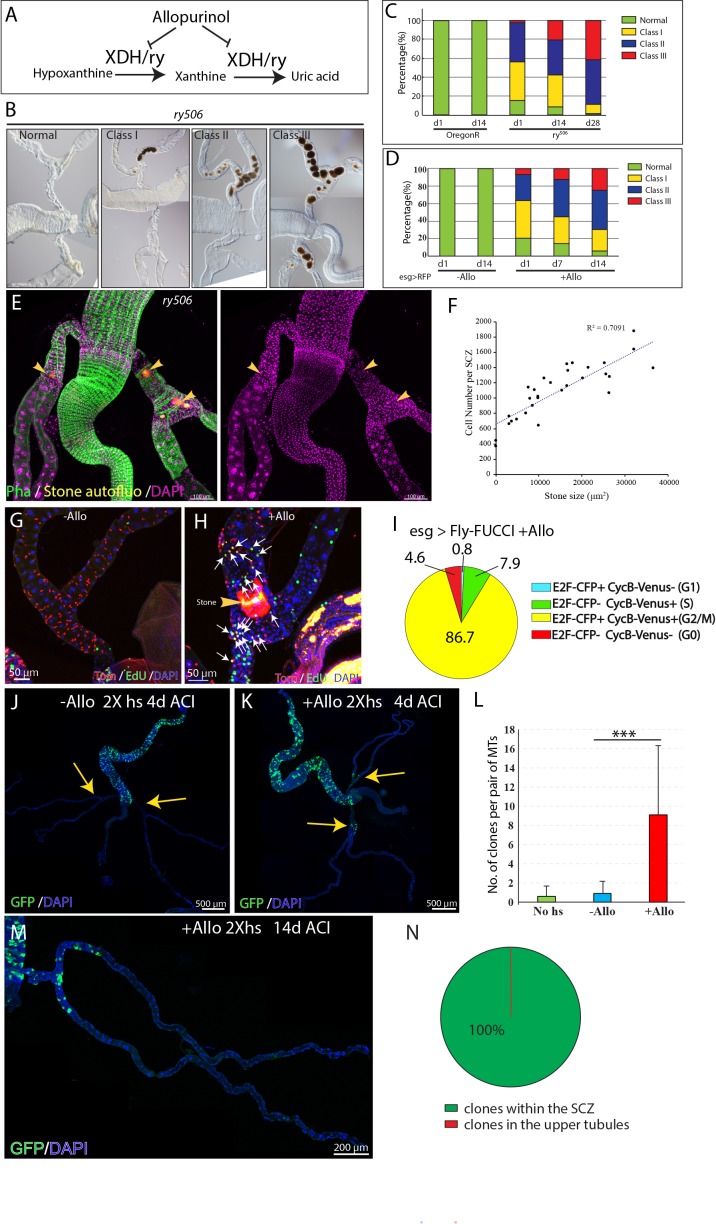
RSCs respond to stone formation.(A) Drosophila ry gene encodes xanthine dehydrogenase (XDH), which catalyzes the conversion of hypoxanthine and xanthine to uric acid. Allopurinol is an inhibitor of XDH. (B–D) Stones progressively developed in ry506 flies and in flies reared on allopurinol food. (B) Representative DIC images of ry506 ureter and lower tubules. Note the stones do not transmit light and hence appear dark. (C and D) Allopurinol feeding recapitulated stone development caused by loss of ry. n = 44–70 animals analyzed. (E) Immunofluorescence micrograph showing a 7 day-old ry506 fly carrying stones (indicated by yellow arrowheads) in the lower tubules and ureters. Note that the SCZ bearing larger stones and more stones contains significantly more cells. (F) Scatter plot showing the correlation between stone sizes (area) and the number of cells present in the SCZ from 7 day-old ry506 flies. (G–H) EdU incorporation in esg+ cells from esg >RFP flies fed on control diet (G) and allopurinol augmented food (H). Note significantly more esg+ cells are EdU+ in allopurinol-treated flies. (I) Fly-FUCCI system was used to assess cell cycle phase distribution of esg+ cells after allopurinol treatment. (J–K) MARCM clones showing clones were barely detectable in control animals with a low dose of heat shock (J), Allopurinol administration increased clone induction in the SCZ with a low dose of heat shock (K). (L) Quantification of MARCM clone numbers in the SCZ with 2X heat shocks 4 days ACI. Data are means ± SD, *** denotes Student’s t test p<0.001. n = 20–49. (M) Representative image showing GFP marked clones 14 days ACI (N) Distribution of clones that were found within the SCZ versus upper tubules. n = 34 animals analyzed. ACI: after clone induction.